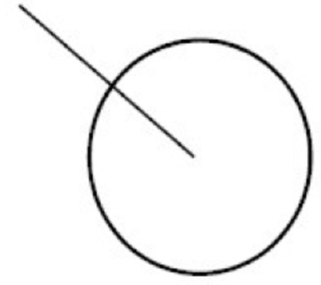
Figure 34 . To get the wave functions of the strings 1 and 3, we make a functional integral in a disc or half in(cid:12)nite cylinder (cid:12)gure 33 constructed described in the manner of the main text.